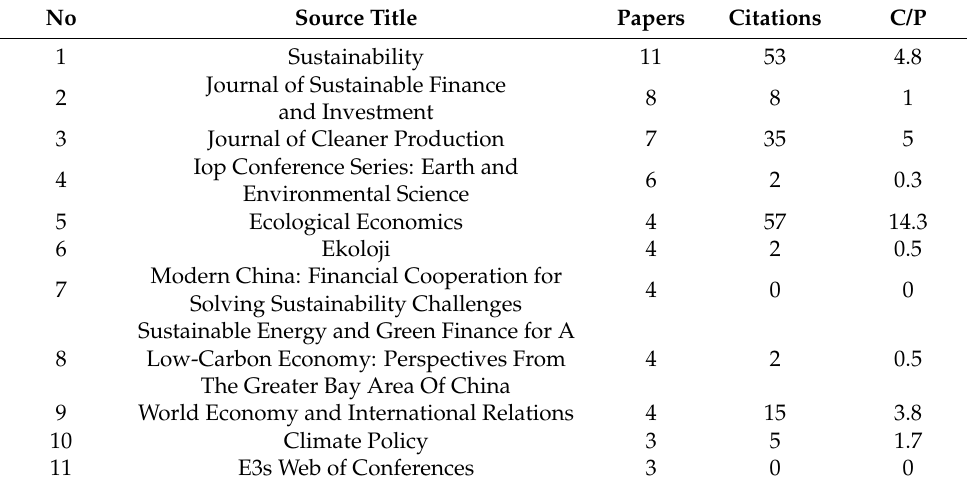
Table 4. Top journals that publish green finance research (line